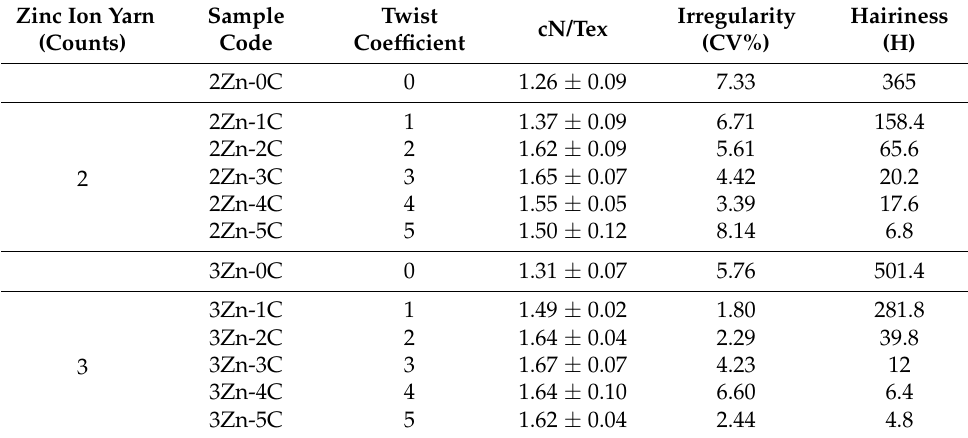
Figure 1. Preparation route of the functional antibacterial nanometer zinc ion yarns. Table 1. Specification of twisted yarns.